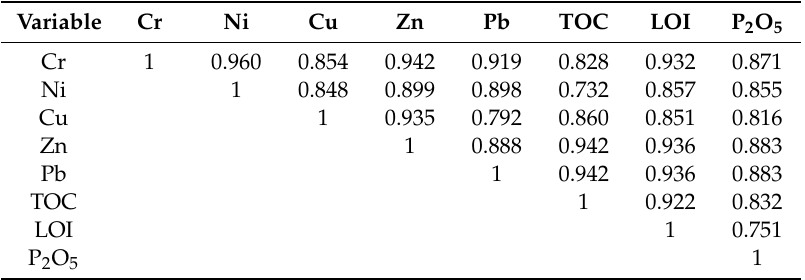
Figure 5. ( a ) Concentrations of Zn versus TOC in the UCRB sediments; ( b ) Concentrations of Zn versus LOI in the UCRB sediments. Table 4. Pearson correlation matrix for heavy metals, TOC, LOI and P 2 O 5 in sediment samples. Correlations are significant at the 0.01 level according to Student’s t-test.